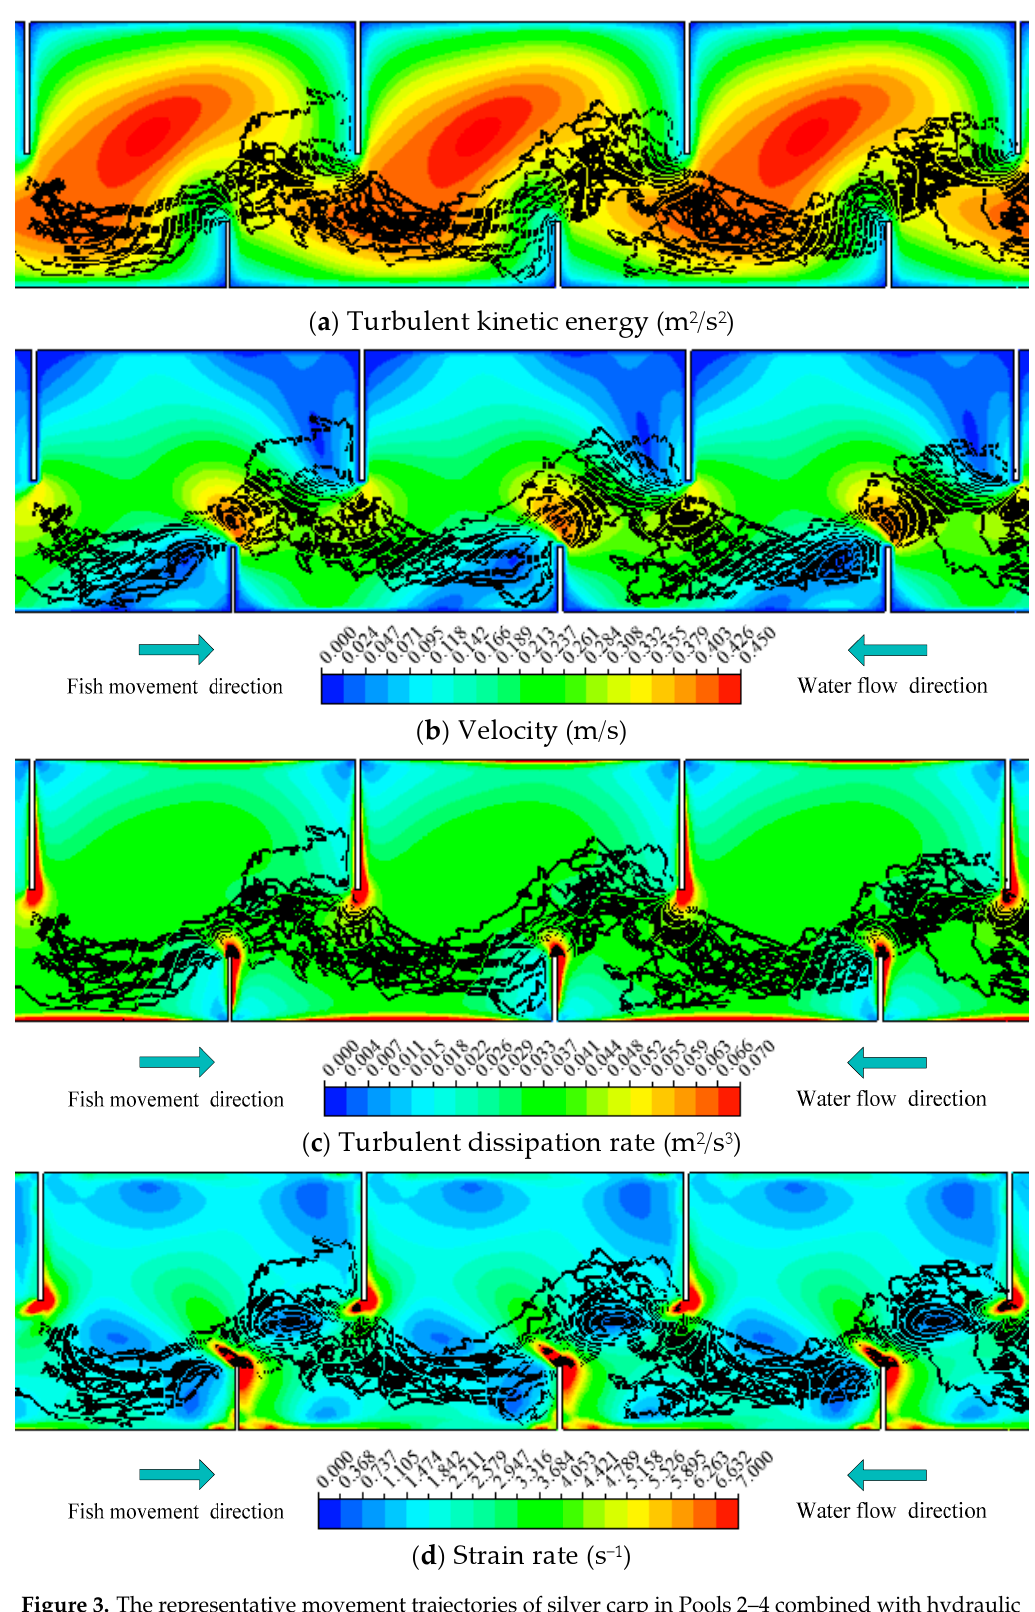
Figure 3. The representative movement trajectories of silver carp in Pools 2–4 combined with hydraulic parameters with Q = 13.5 L/s (Z = 0.3 h): ( a ) Turbulent kinetic energy (TKE); ( b ) Velocity (V); ( c ) Turbulent dissipation rate (TDR); ( d ) Strain rate (SR) in the experimental